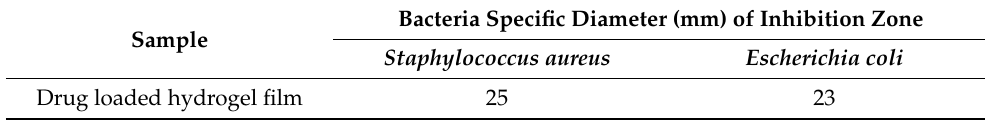
Table 3. Zone of inhibition (mm) in drug loaded hydrogel sample.